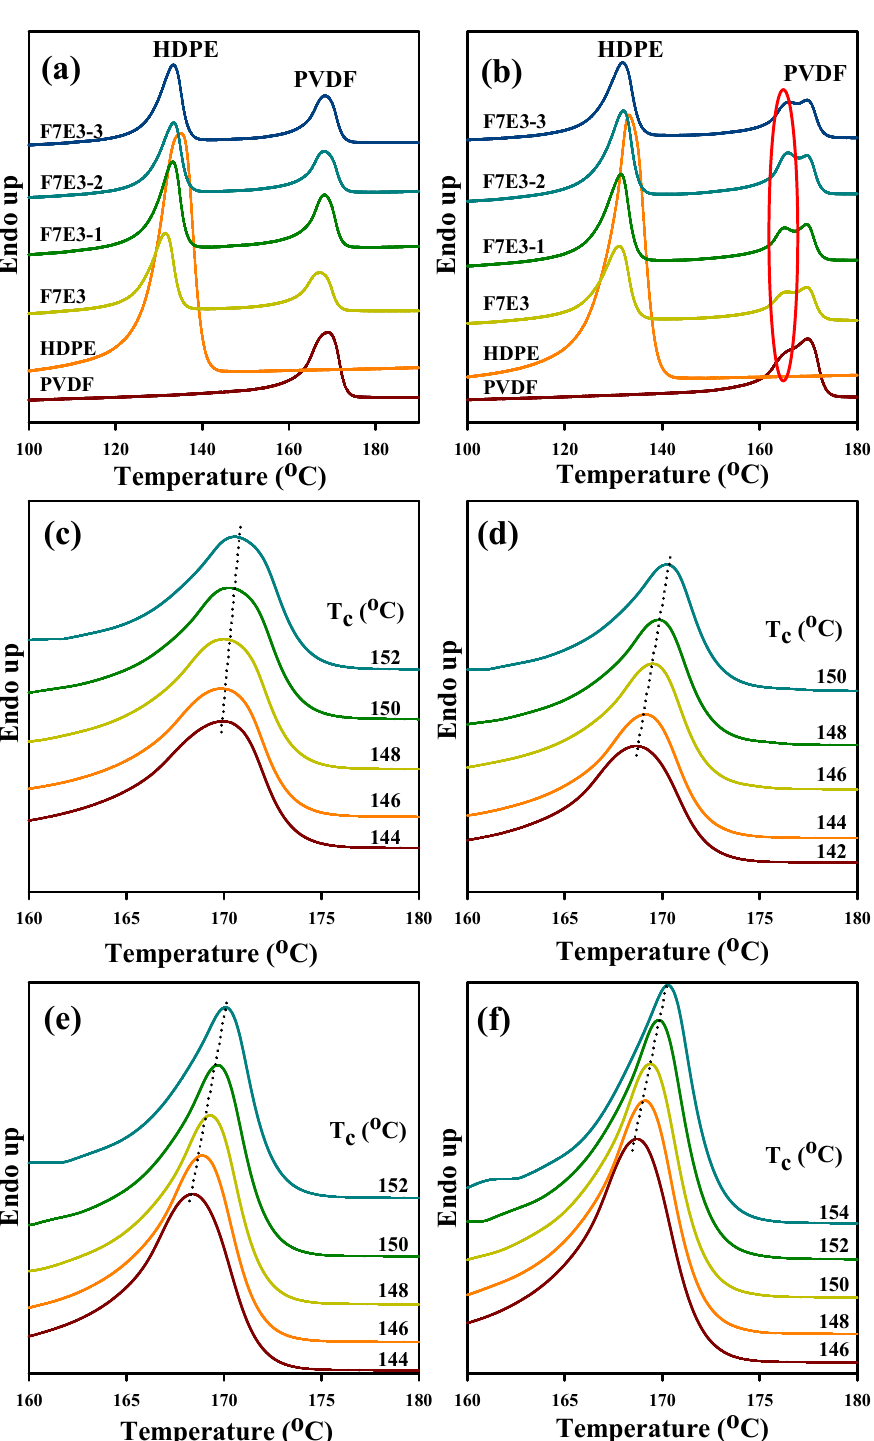
Figure 6. DSC heating curves of different samples: ( a ) 5 °C/min pre-cooled and ( b ) 40 °C/min pre-cooled; DSC melting curves of PVDF isothermally crystallized at indicated T c s in different samples: ( c ) PVDF, ( d ) F7E3, ( e ) F7E3-1, and ( f ) F7E3-3.